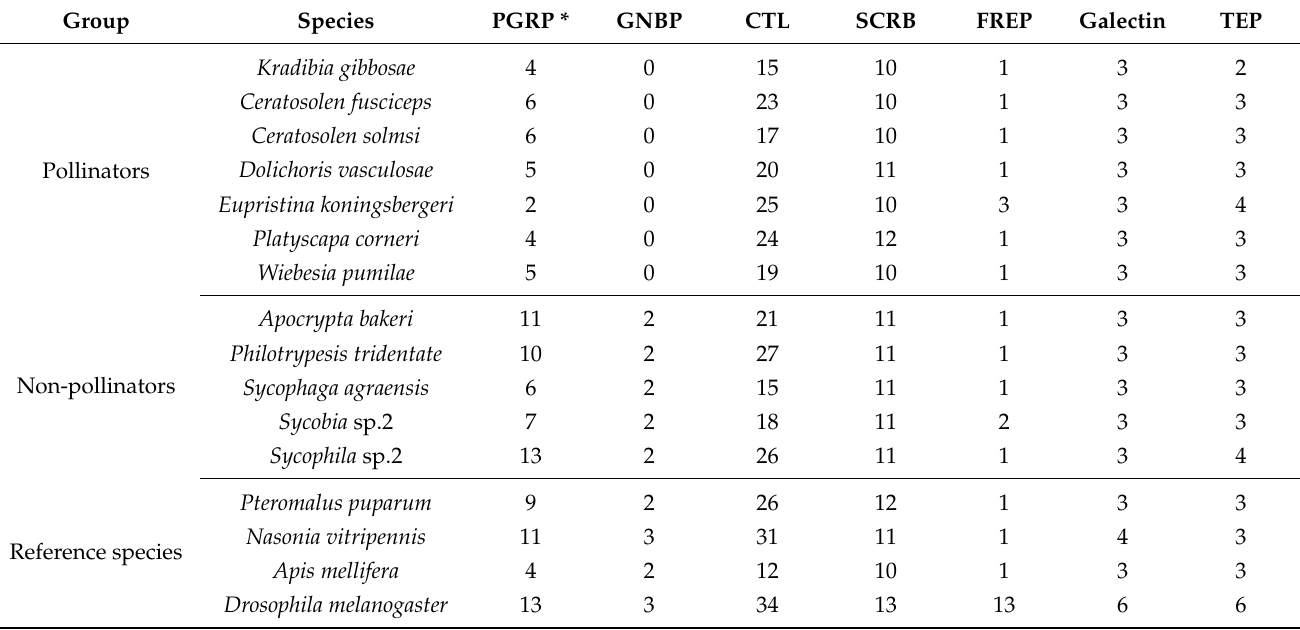
Table 1. Gene number of pattern recognition receptors of the 12 fig wasp species and four reference species. Group